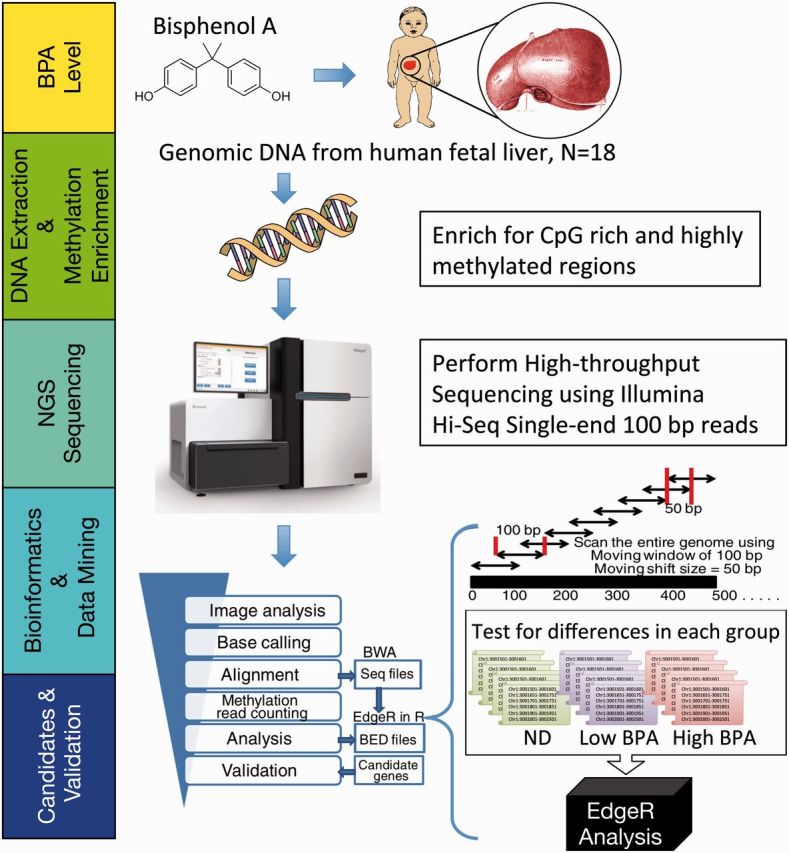
schematic overview of experimental design from BPA quantification in human fetal liver
tissue through next-generation sequencing and analysis to identify RAMs. ND,
non-detect